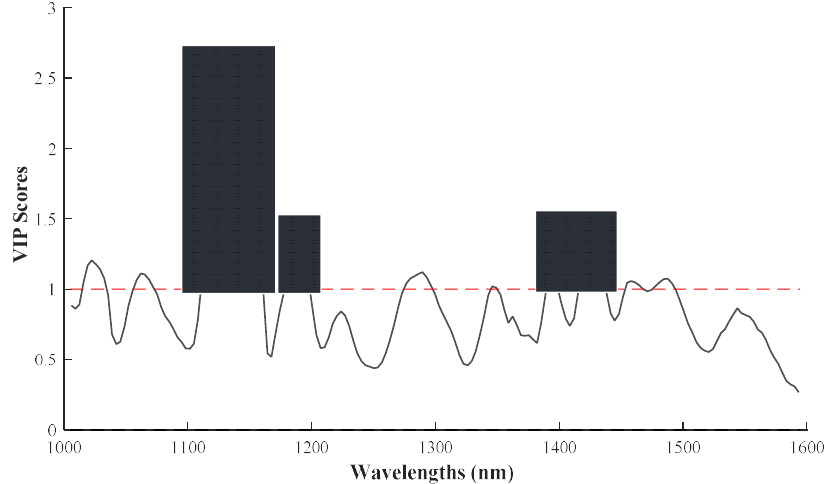
Figure 4. VIP scores for the discrimination of almonds by bitterness.